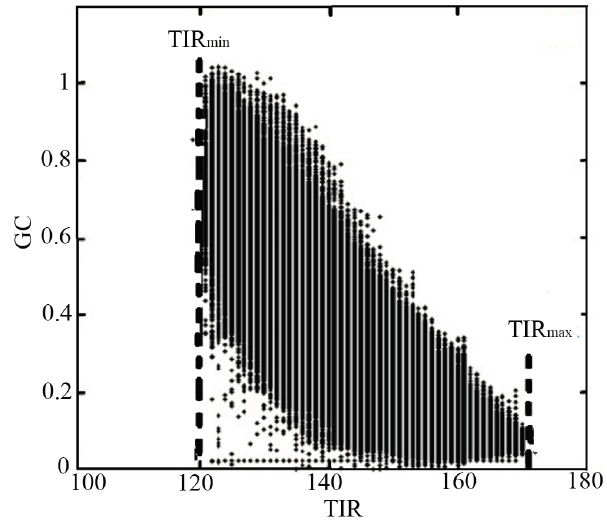
Figure 2. Result of plotting GC vs. raw thermal infrared digital count data ( TIR ) for pixels making up a medium-resolution multispectral satellite image of an agricultural